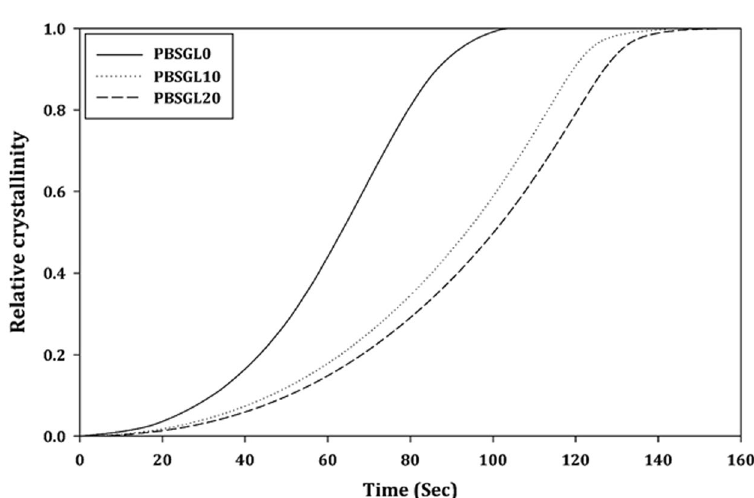
Figure 3. Development of non-isothermal relative crystallinity over time for PBSGL n